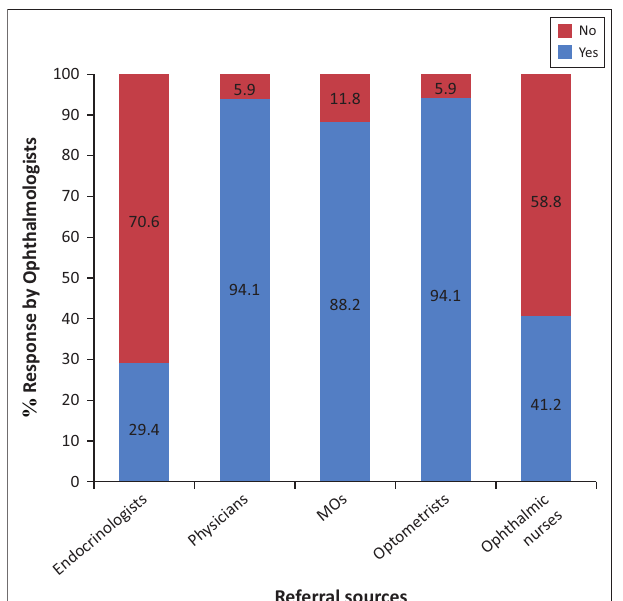
FIGURE 9: Referral sources to